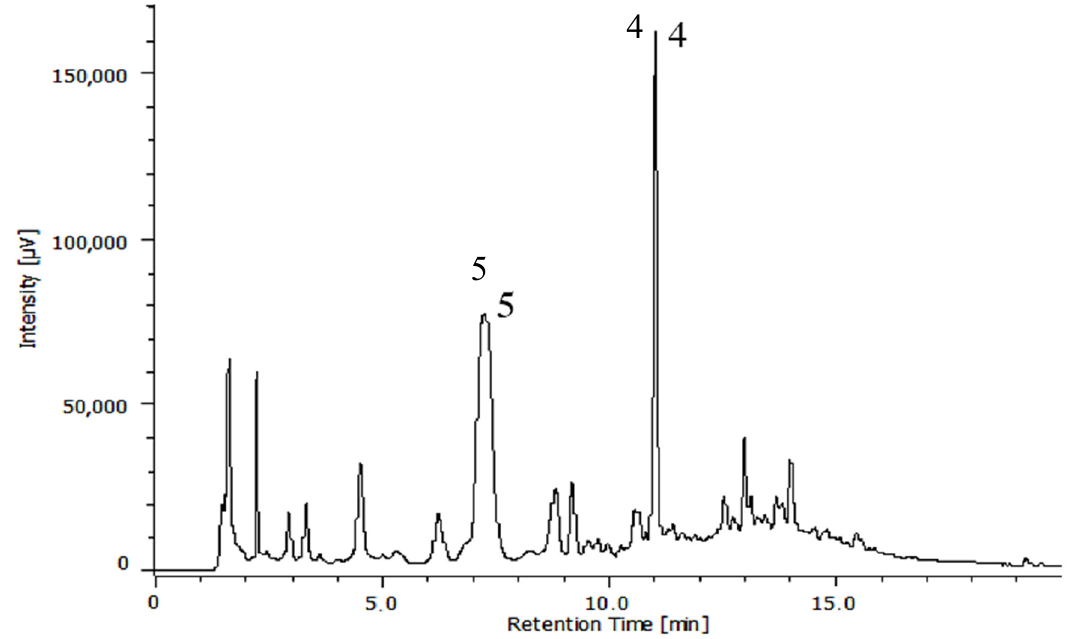
Figure 1. HPLC-PAD analysis of hydroalcoholic extract from the M. hirtum .